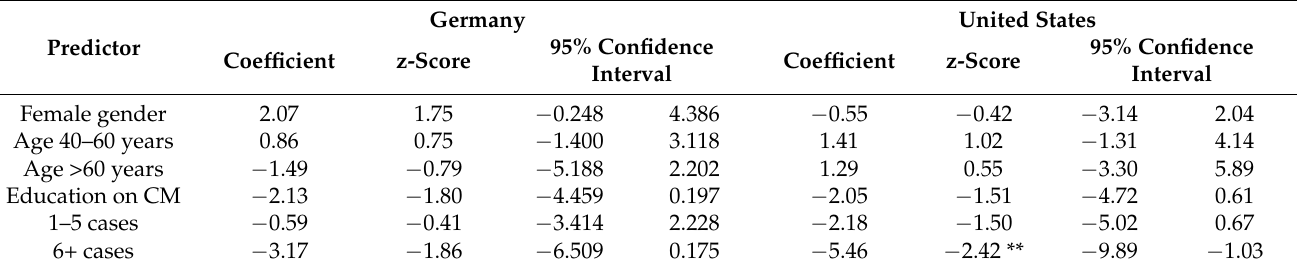
Table 3. Predictors for reasonable suspicion using an estimated probability scale. Differential Diagnosis and Estimated